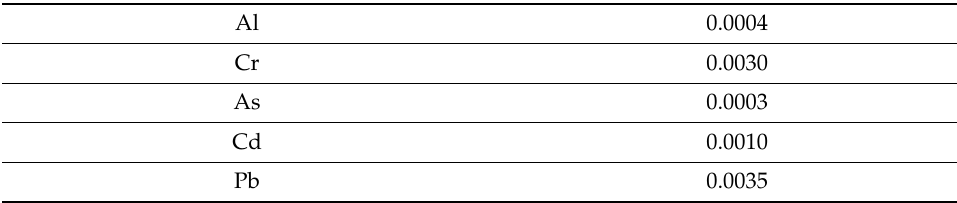
Table 4. Oral reference value of metallic or metalloid element (mg/kg · d).